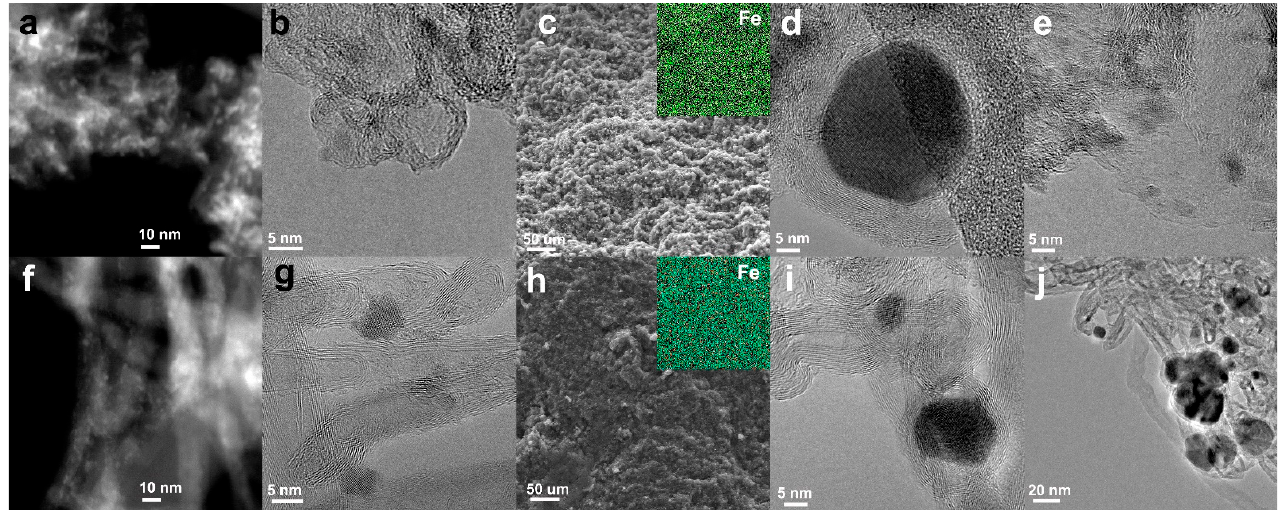
Figure 1. TEM images of FeKNGNF ( a , b ), sintered FeKNGNF700 ( d , e ), FeKNCNT ( f , g ) and FeKNCNT800 ( i , j ); SEM images of FeKNGNF700 ( c ) and FeKNCNT800 ( h ) (insets show corre- sponding EDX iron